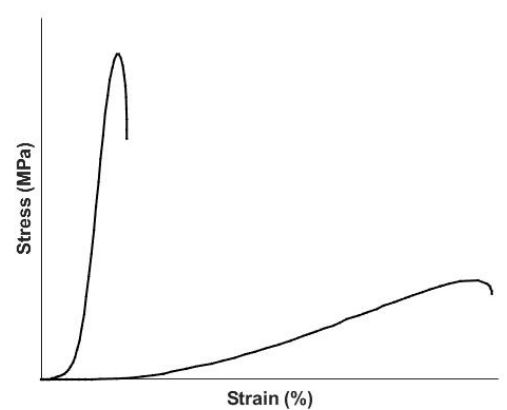
Figure 9. Diagrammatic representation of the stress-strain curves for different extracellular matrices containing collagen fibers. The curve on the left represents the behavior of tendon which contains collagen fibers that run almost parallel to the axis of the tendon. In contrast, skin exhibits a long low modulus region associated with stretching of the elastic fibers and a high modulus region associated with alignment of the collagen fibers with the loading